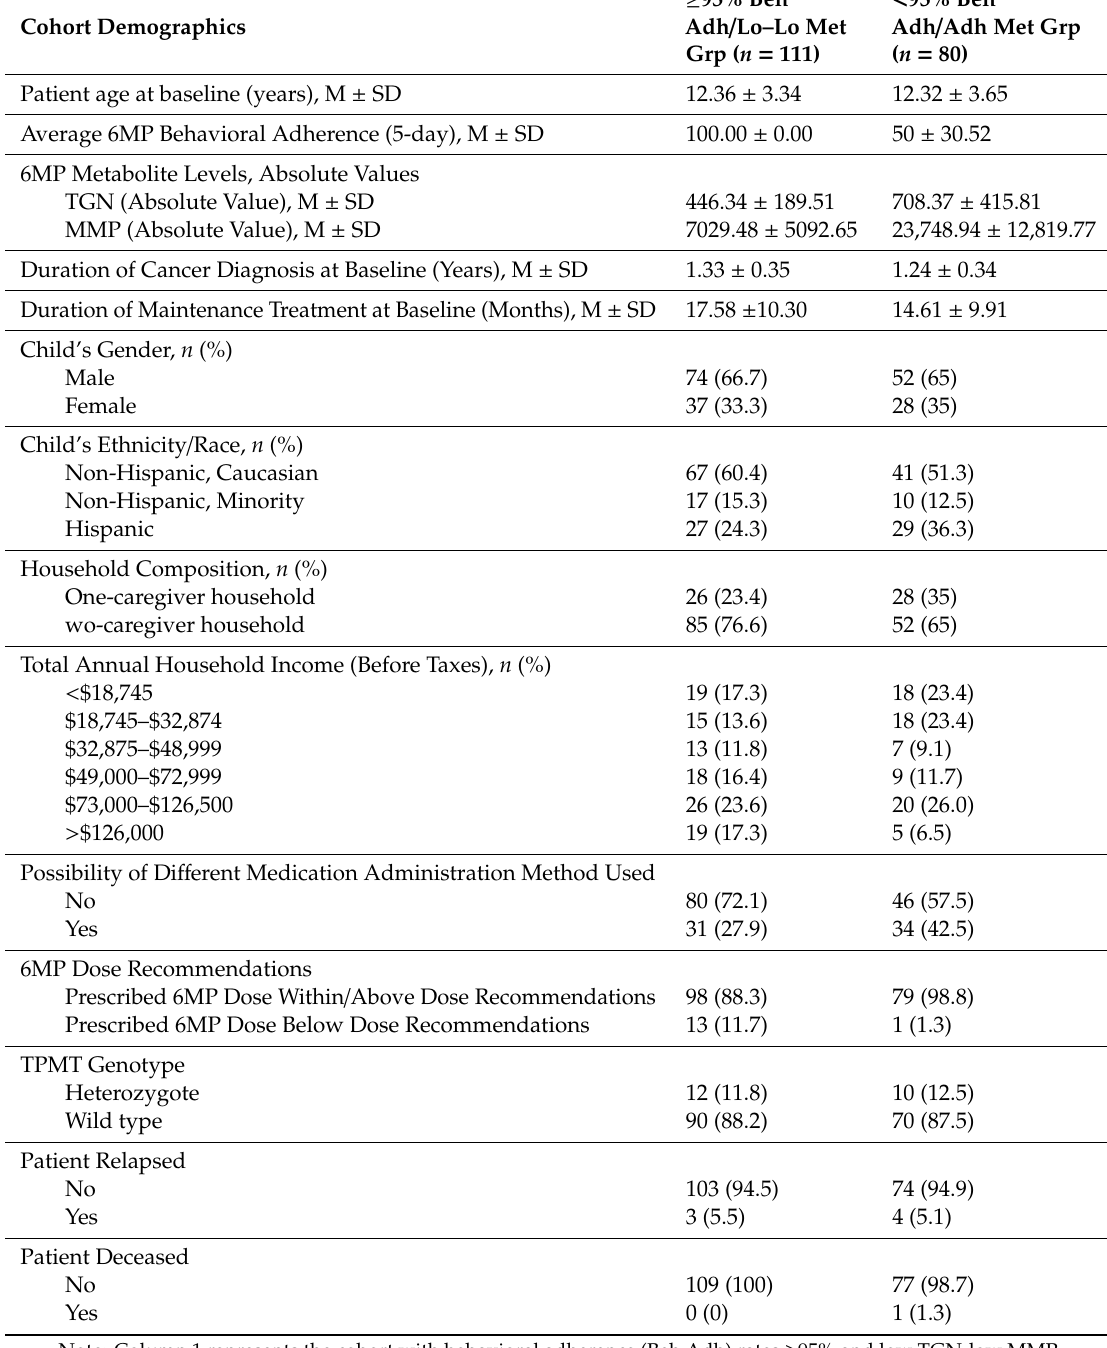
Table 1. Demographic and medical characteristics of incongruent adherence profiles across 15